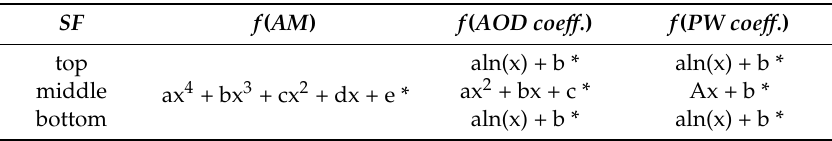
Table 1. Proposed spectral corrections for each subcell. SF : spectral factor; AM: air mass; AOD coeff. : aerosol optical depth coefficients; PW coeff .: precipitable water